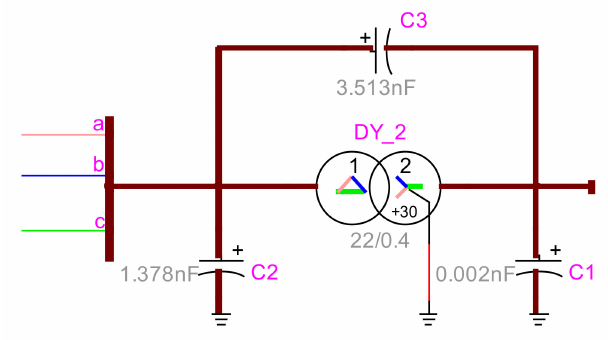
Figure 3. ∆ Y-connection model of the transformer with measured